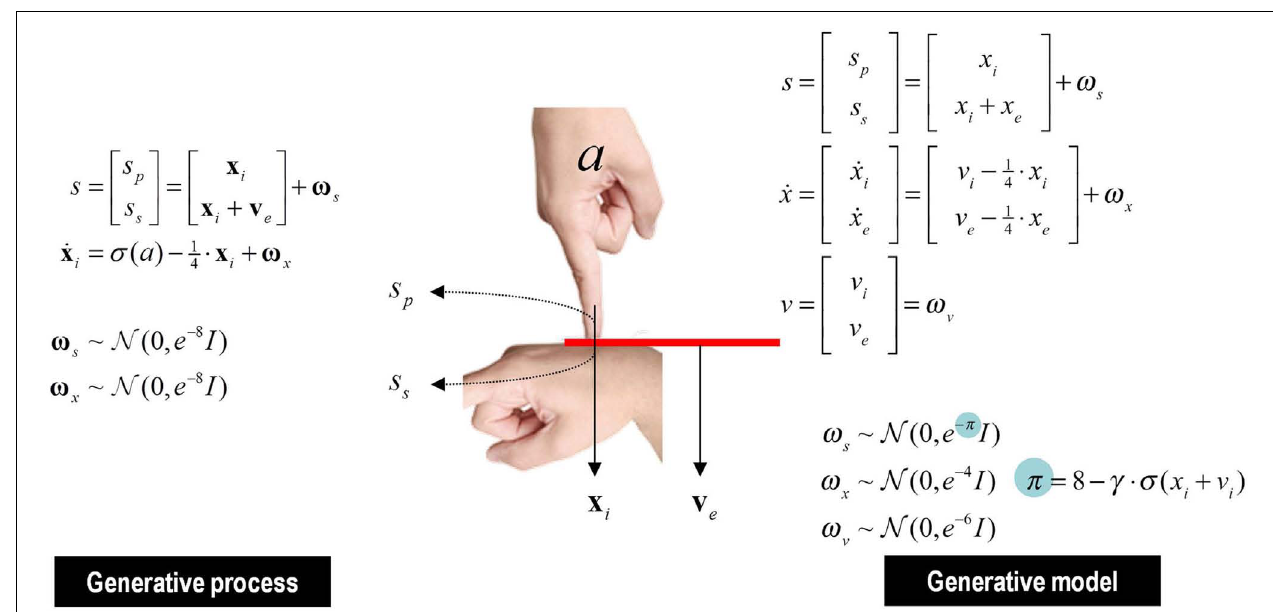
In the generative model, causes of sensory data are divided into internal v i and external causes v e .The hidden cause excites dynamics in hidden states x i and x e , which decay slowly. Internal force is perceived by both proprioceptive and somatosensory receptors, as before, while external force is perceived only by somatosensory receptors. Crucially, the precision of the sensory input ω s is influenced by the level of internal force, again modulated by a squashing function, and controlled by a parameter γ that governs the level of attenuation of precision.The generalized predictive coding scheme associated with this generative model is shown schematically in the next figure.